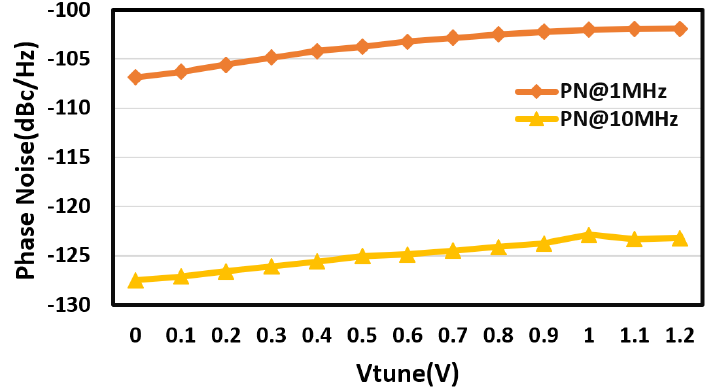
Figure 12. Phase noise vs. frequency. Table 1. Performance summary of different